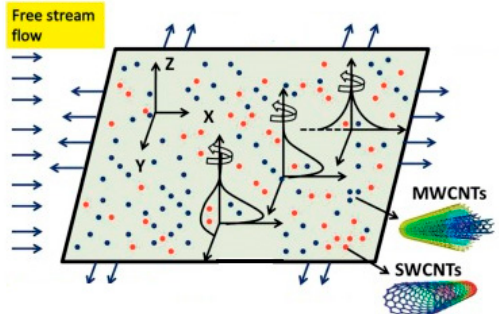
Figure 1. The outline of the problem. MWCNTs: multi-wall carbon nanotubes; SWCNTs: single-wall carbon nanotubes.